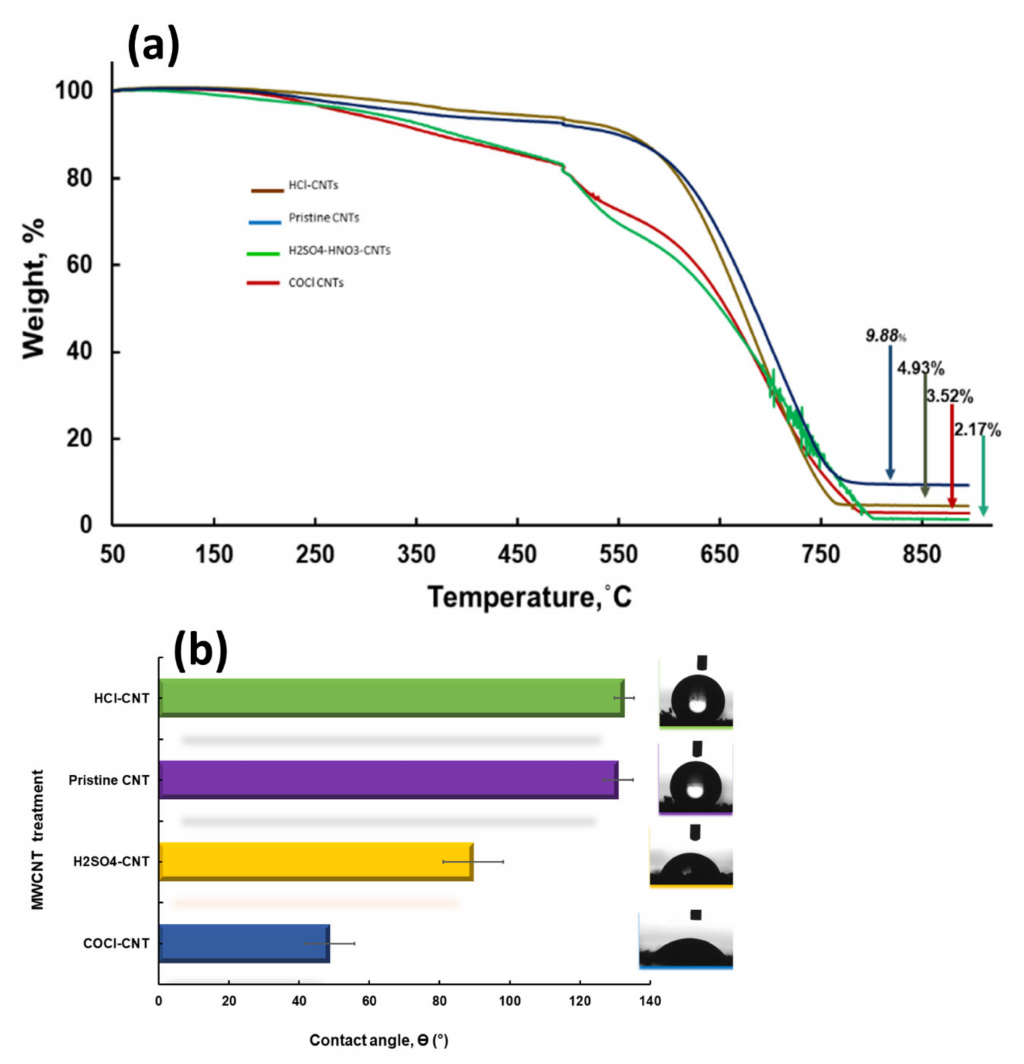
Figure 5. VA-MWCNTs properties. Thermogravimetric properties ( a ) and wetting properties ( b